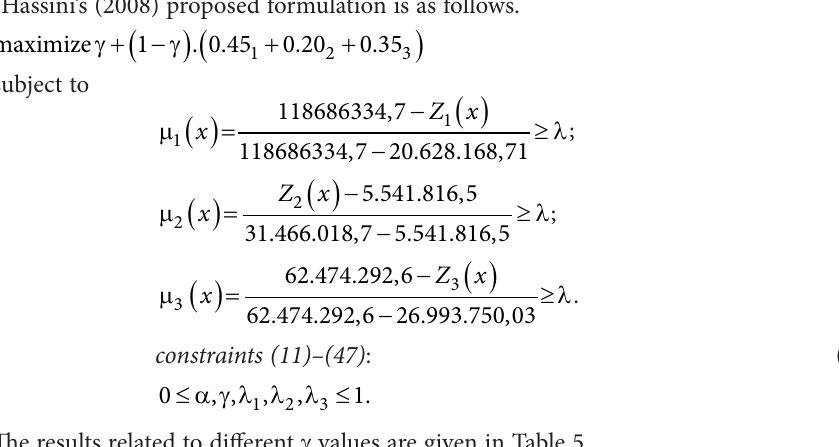
Table 5. The optimum values related to the different g values Obj. Gama Alfa